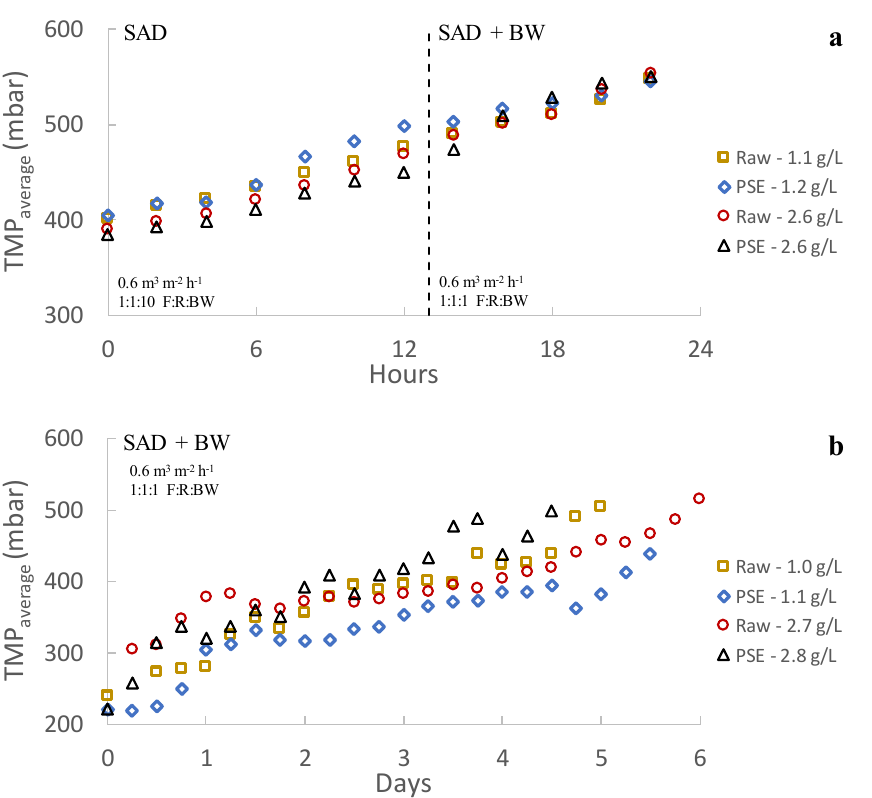
Figure 5. Influence of the applied reversible fouling control strategies (increase in sparging air intensity and backwashing periodicity) on the membrane fouling development: ( a ) ultrafiltration membrane and ( b ) microfiltration membrane. SAD: specific air demand. BW: backwashing. F:R:BW: backwashing periodicity, i.e., filtration:relaxation:backwashing ratio. Raw: influent municipal wastewater after a classic pre-treatment (screening and sieving, desanding and degreasing). PSE: effluent of the full-scale wastewater treatment plant primary settler.